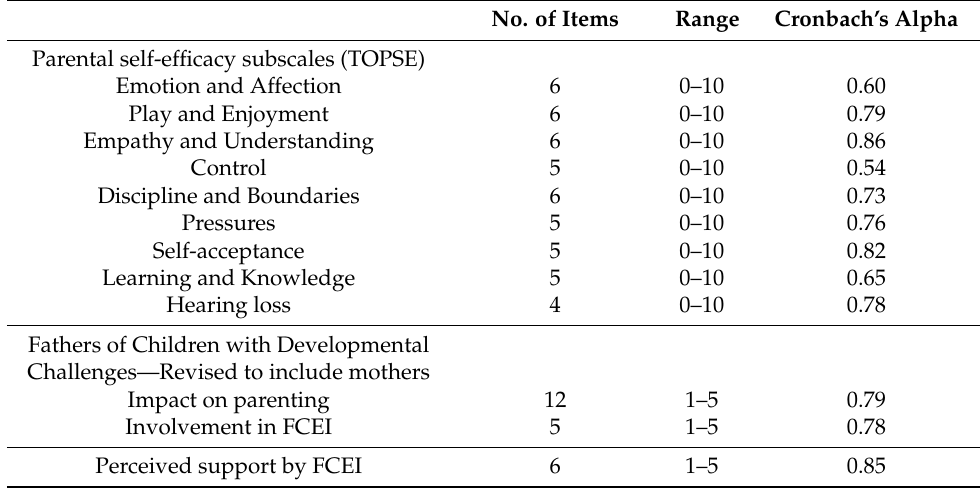
Table 2. Psychometrics of the